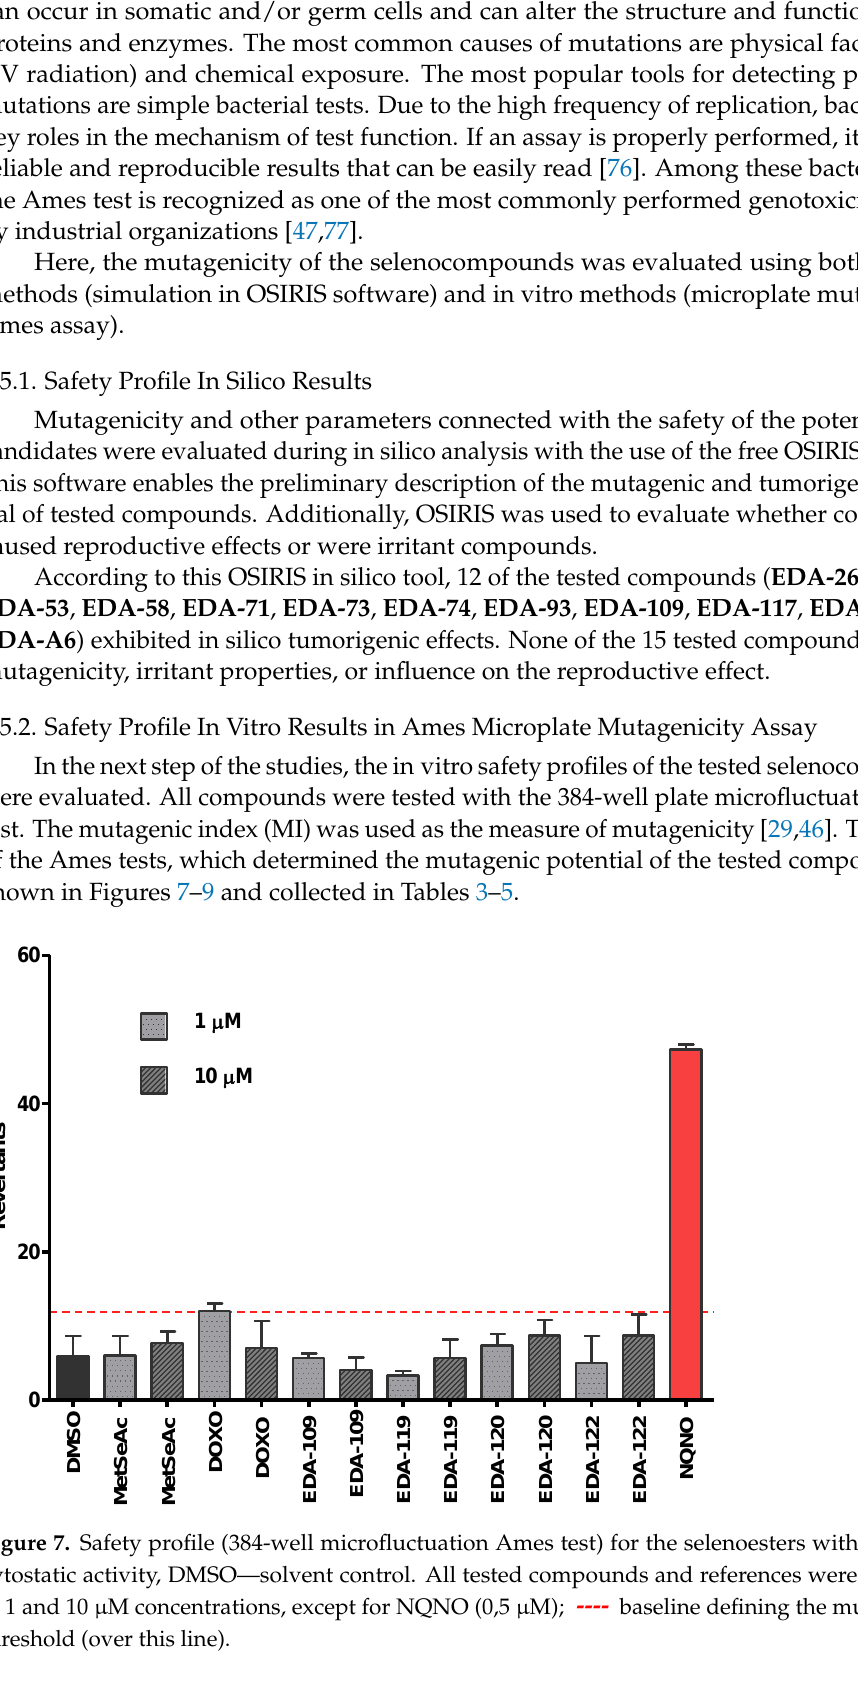
Table 3. Mutagenic index (MI) and other values for methylseleninic acid (reference Se compound), doxorubicin (reference chemotherapeutic), and tested compounds with high cytostatic activity.